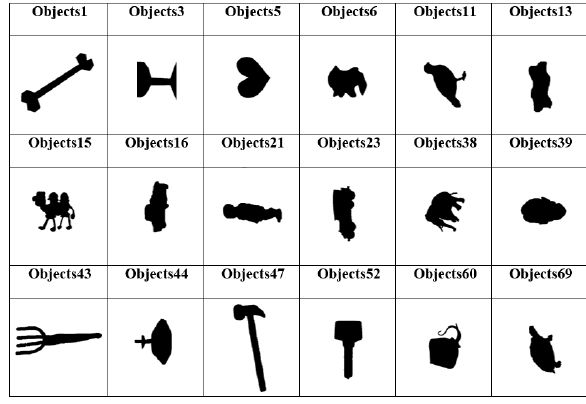
Figure 10: Examples of classes dataset Kimia-216.